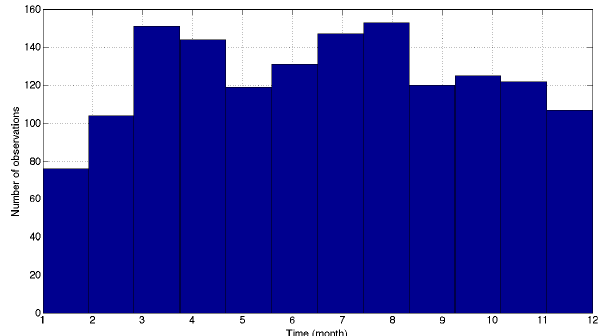
Figure 2. Histogram showing the number of observations in func- tion of the month between 1998 and